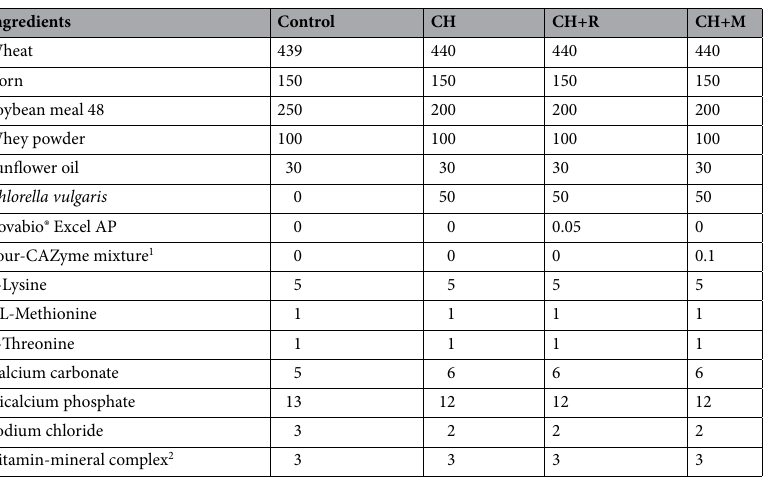
Table 5. Ingredients and feed additives of the experimental diets (g/kg). Dietary treatments: Control—control diet; CH—5% Chlorella vulgaris diet; CH+R— Chlorella vulgaris diet supplemented with 0.005% Rovabio Excel AP; CH+M— Chlorella vulgaris diet supplemented with 0.01% enzymatic mixture. 1 exo-β-glucosaminidase, an alginate lyase, a peptidoglycan N-acetylmuramic acid deacetylase and a lysozyme (CPE1314). 2 Premix provided per kg of complete diet: vitamin A, 6500 UI; vitamin D3, 1500 UI; vitamin E, 15 mg; vitamin K3, 1 mg; vitamin B1, 1 mg; vitamin B2, 3 mg; vitamin B6, 2 mg; vitamin B12, 0.02 mg; pantothenic acid, 10 mg; nicotinic acid, 15 mg; folic acid, 0.5 mg, biotin, 0.03 mg; betaine, 115 mg; vitamin C, 20 mg; Copper, 100 mg; iron, 100 mg; iodine, 0.5 mg; manganese 50 mg; selenium, 0.15 mg; zinc, 100 mg; butylated hydroxytoluene, 3